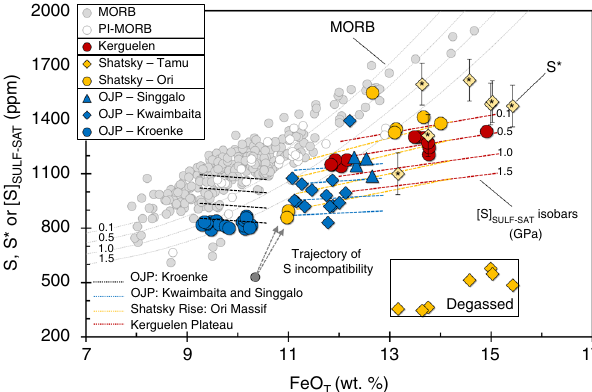
Fig. 2 Pressure effects on sulfur solubility during crustal differentiation of OPB and MORB. [FeO T ] versus [S] for OPB samples and calculated [S] ([S*] = [Se] Tamu × S/Se Ori ) of Tamu Massif samples prior to degassing (yellow starred diamonds). [FeO T ] versus [S] SULF-SAT isobars (dashed thin lines) at four pressure intervals (0.1, 0.5, 1.0 and 1.5 GPa) are given for MORB and OPB suites and are calculated using the model of Smythe et al. 12 . MORB samples plot along the low pressure (~0.1 GPa) [S] SULF-SAT isobar because they are sul fi de-saturated during low-pressure differentiation. OPB suites plot along modeled [S] SULF-SAT isobars at various pressures, suggesting that the different OPB suites may have stalled and differentiated at different pressures. Importantly, this also suggests that OPB magmas are sul fi de-saturated, because they do not follow a steeper ” D = 0 ” trajectory denoted by the gray-dashed arrow. Despite lying close to the 1.5 GPa isobar, the high [Pt] of the Kroenke samples (see SI) suggests that they were sul fi de-under-saturated following ascent and consequently, eruption on the sea fl oor. The Tamu Massif samples are offset to low [S] at a given [FeO T ] compared to the Ori Massif samples, because they are degassed. Estimated [S] concentrations prior to degassing ([S*]) are